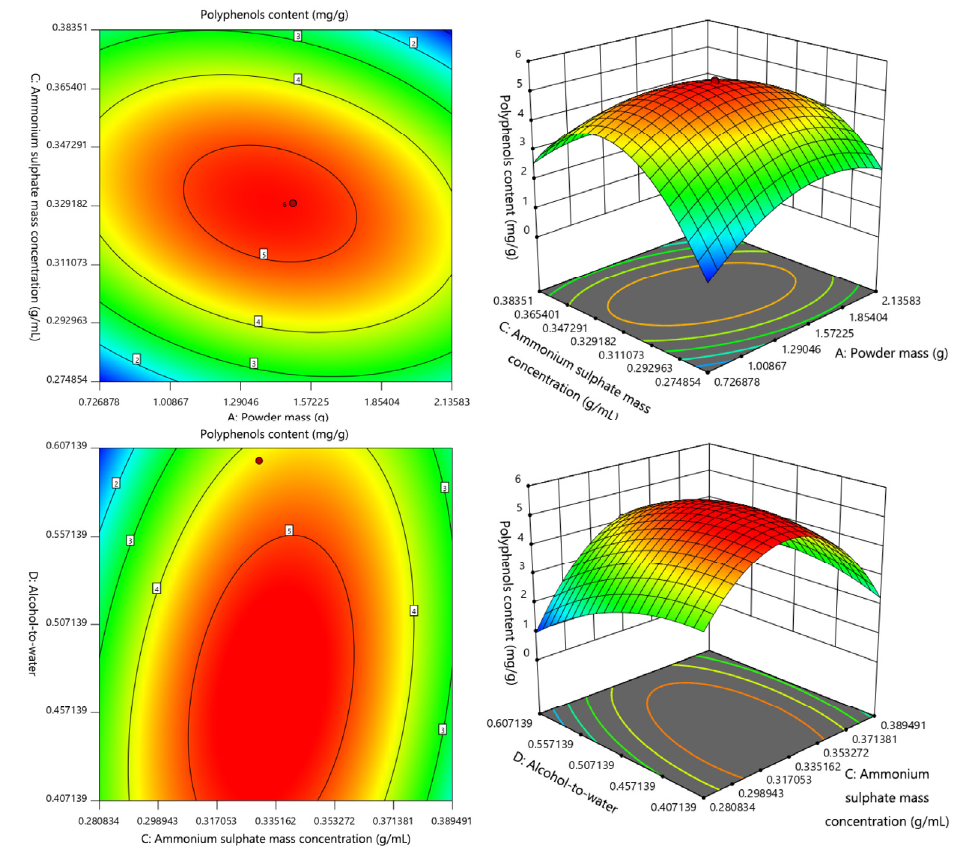
Figure 1. Effect of interaction between the powder mass (A) and the ammonium sulfate concentration (C) or the alcohol–water ratio (D) on the polyphenol